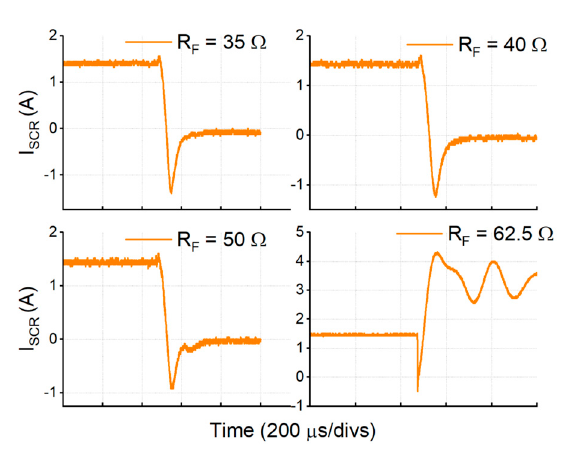
Figure 9. The ZCB’s cutoff behavior in the cases of the two-times multiplication factor.